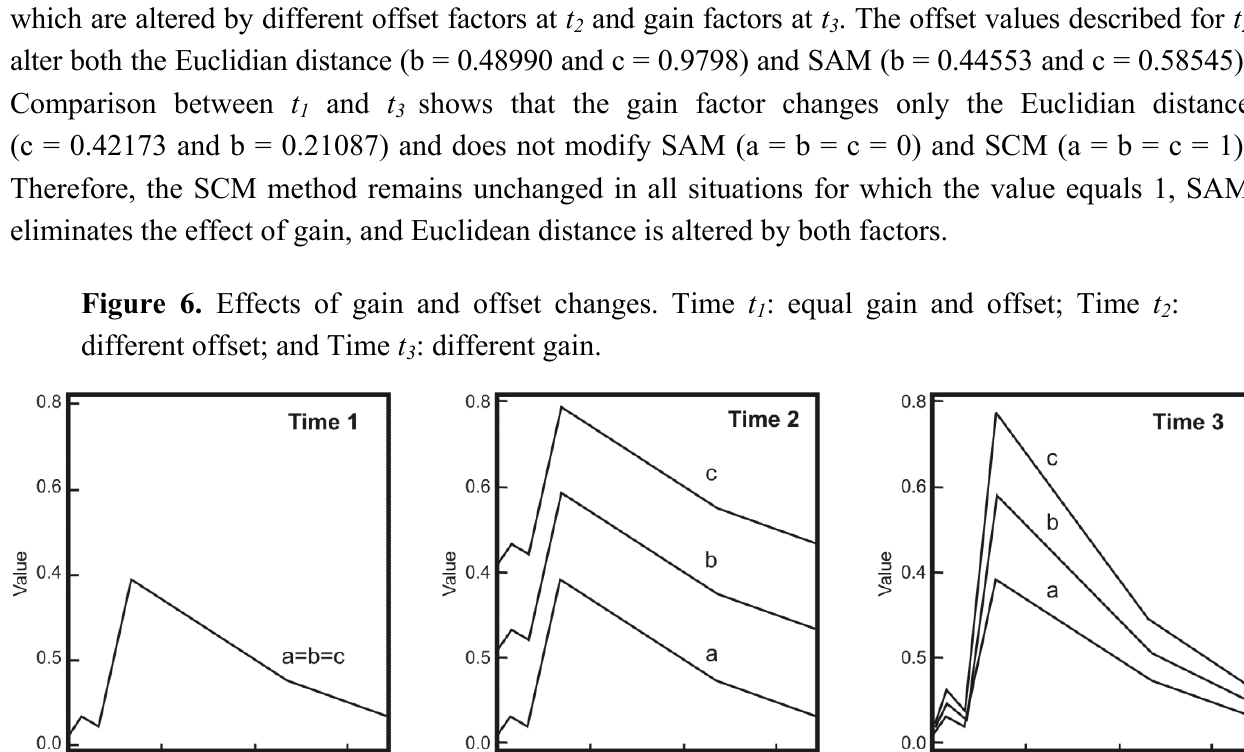
: equal gain and offset; Time t 1